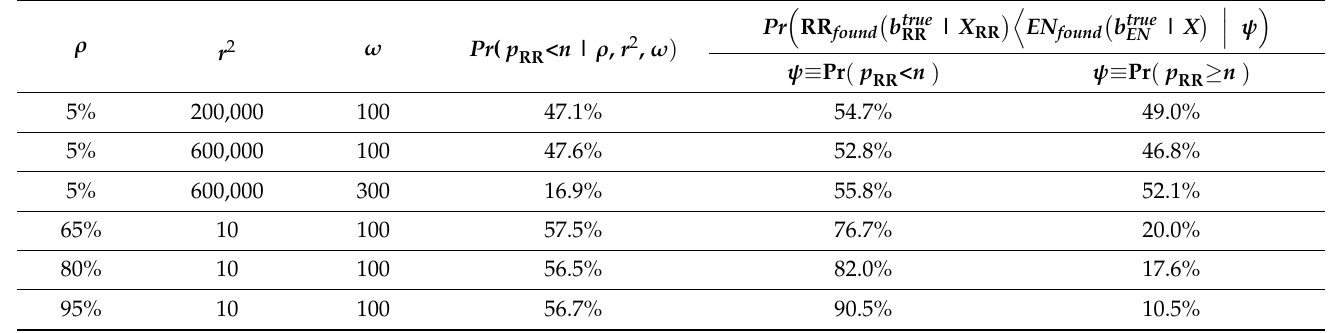
(cid:12) (cid:0) (cid:1) < b true EN found (cid:12) X RR RR